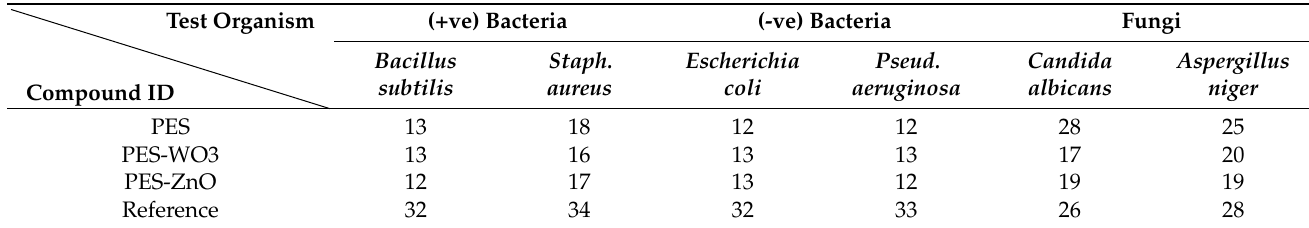
Table 2. Antimicrobial activity of PES, PES-WO 3 , and PES-ZnO, measured by (mm).